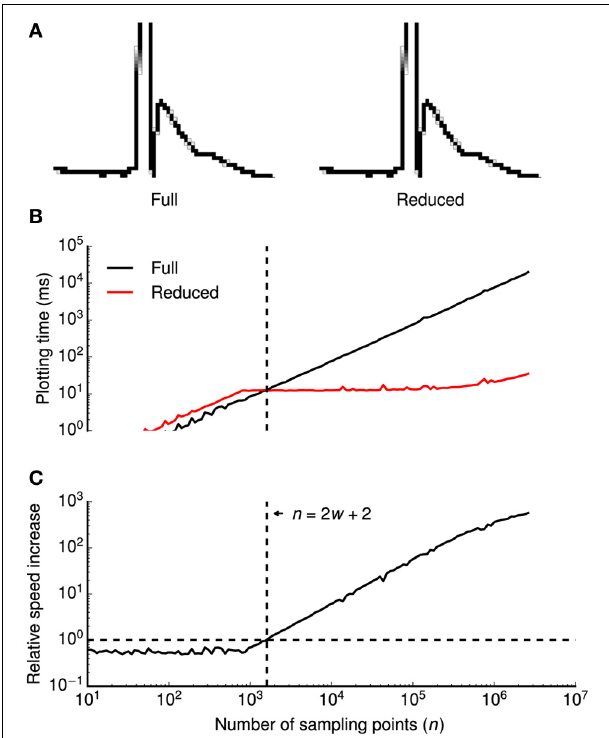
FIGURE 2 | Data reduction benchmark. A data reduction algorithm provides up to ∼ 500-fold speed increase without visual information loss. (A) High-magnification view of individual pixels when all consecutive points in a time series (a clipped action potential) are connected by lines (left) or when a data reduction algorithm is applied (right). While the algorithm reduces the amount of plotted lines by a factor of ∼ 16 in this example, all details of the time series are visually preserved. Gray shaded pixels are caused by the anti-aliasing algorithm of the line drawing back-end. (B,C) Plotting times ( B ) and relative speed increase by the data reduction algorithm ( C ) were plotted double-logarithmically against the number of sampling points n of the time series. Relative speed increase was computed as the ratio of plotting times without and with data reduction. In (B) , plotting times are shown with (red) and without (black) data reduction. Vertical dashed lines in (B,C) denote the minimumnumberofsamplingpoints n thatisrequiredforthealgorithmtobe beneficial(speedincrease > 1.0),indicatedbyahorizontaldashedlinein (C) at a horizontal screen resolution w (800 pixels in this example). Plotting times were measured for a 800 × 600 pixels window running on OS X.